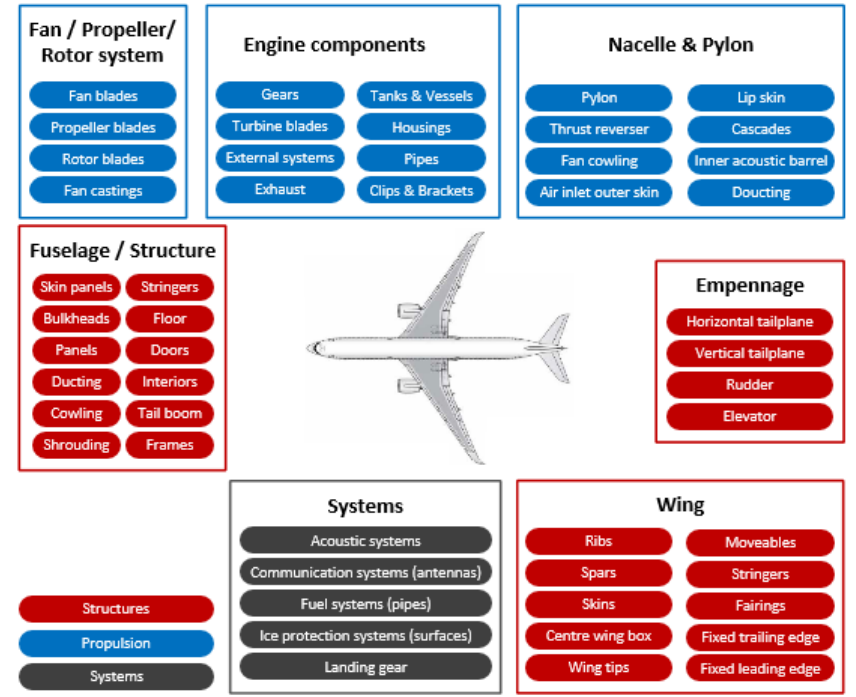
Figure 1. The use of composite materials in the construction of an aircraft (adopted from Aerospace Technology Institute, 2017)